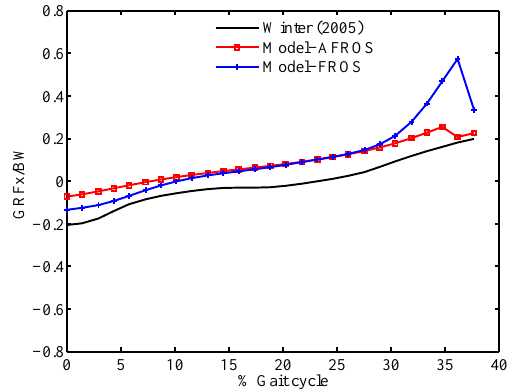
Figure 14. GRFx results for SS phase – experimental data and results for AFROS and FROS foot models using GRFy and the as- sumption that the GRF vector passes through the COM. (Gait cycle starts at toe-off of the other leg, that is, at the beginning of SS.)